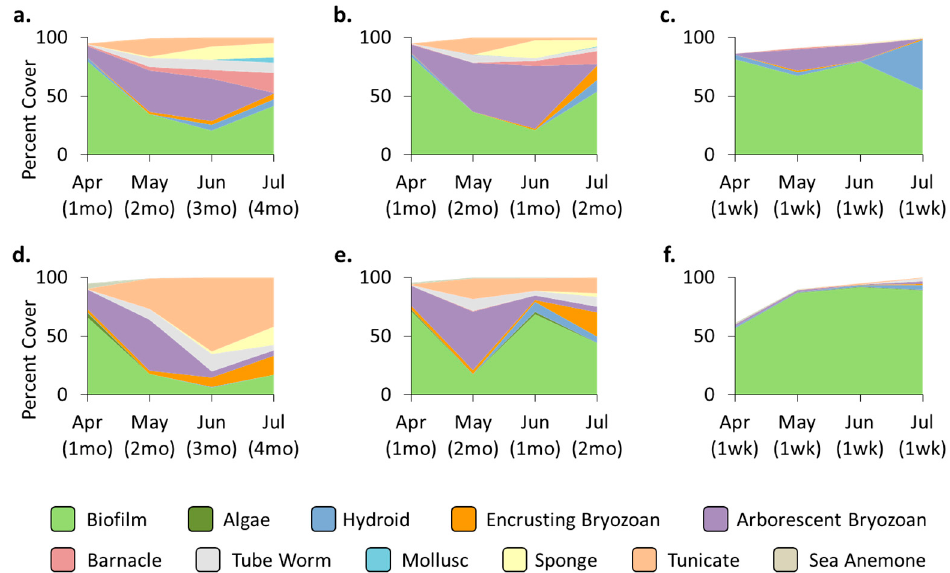
Figure 5. Fouling community structure on DC3140 at Sebastian ( a – c ) and Port Canaveral ( d – f ). The first column ( a , d ) are the uncleaned panels, the second ( b , e ) are cleaned and the third ( c , f ) are the groomed panels. The X-axis is the sampling month and the Y-axis is average percent cover.